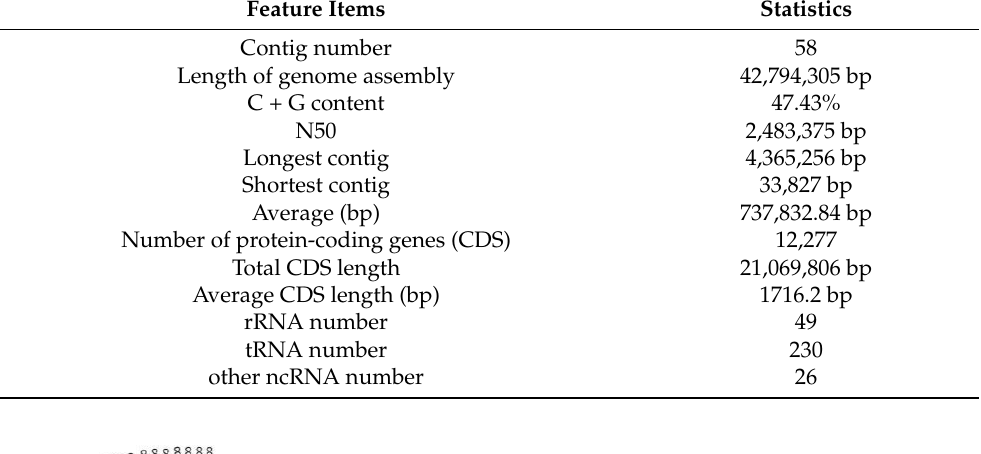
Table 1. Genome assembly statistics of C. unicolor SP02 genome.